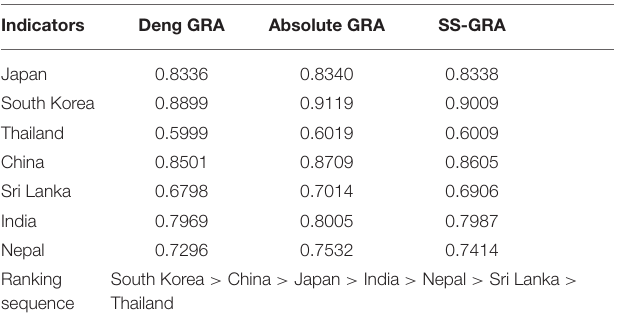
TABLE 2 | Grey assessment between IHD mortality and exposure to ambient PM 2.5 .